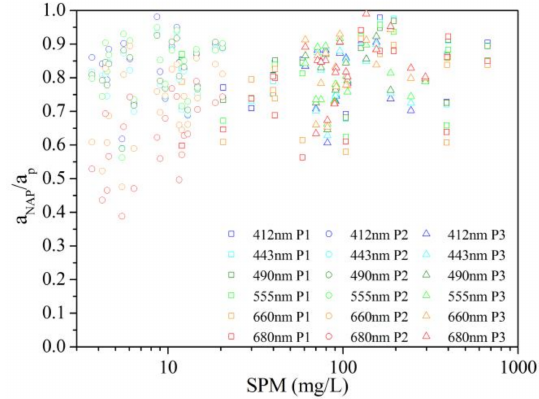
Figure 8. Variations of the non-algal to total particle absorption ratio (a NAP /a p ) at different wavelengths as a function of the SPM concentration at Stations P1 (squares, N = 16), P2 (circles, N = 22) and P3 (triangles, N=18). Different colors represent different wavelengths. The contributions of a NAP ( λ ) to a p ( λ ) were more than 56.4% and 60.7% at all main wavelengths for Stations P1 and